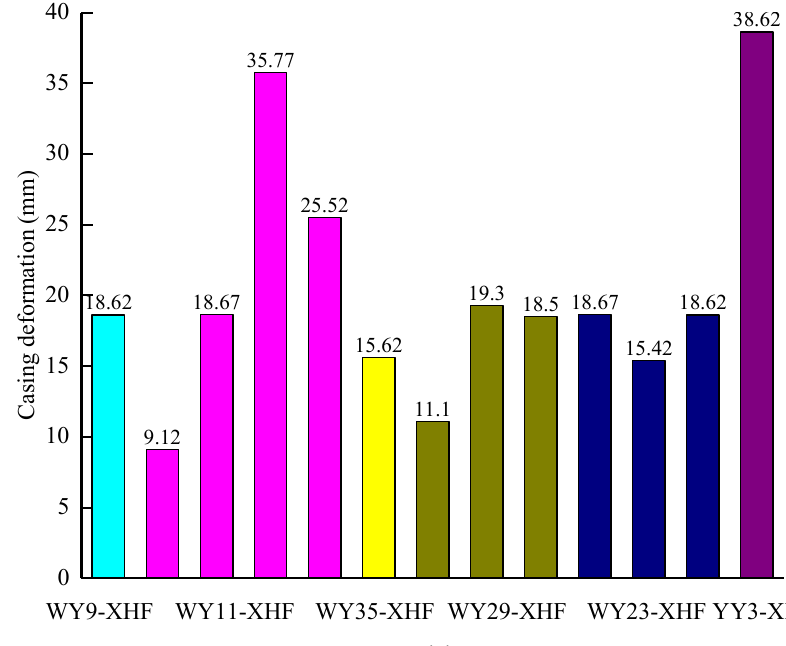
Figure 2. Statistics on casing deformation of some shale gas wells.